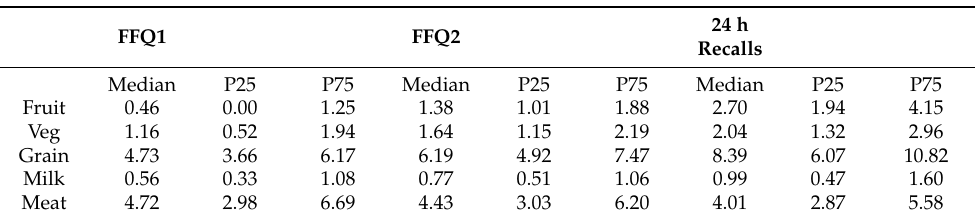
Table 4. Median nutrients intake from the two FFQ surveys and average of the 24 h dietary recalls among adults in Qatar.